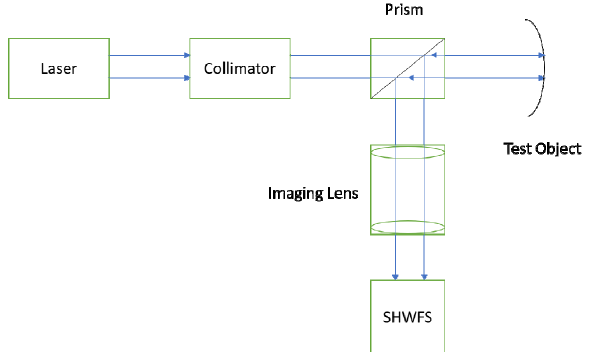
Fig. 6 Schematic of the system setup.